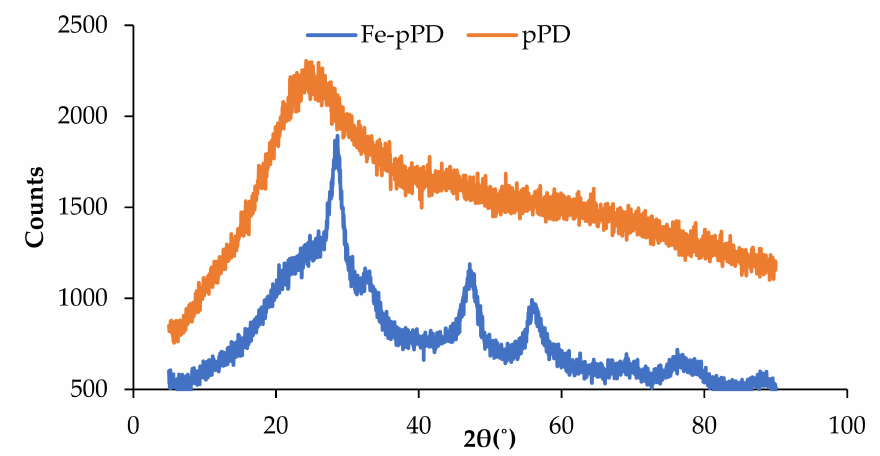
Figure 4. XRD diffractogram of pPD and Fe-pPD composite.